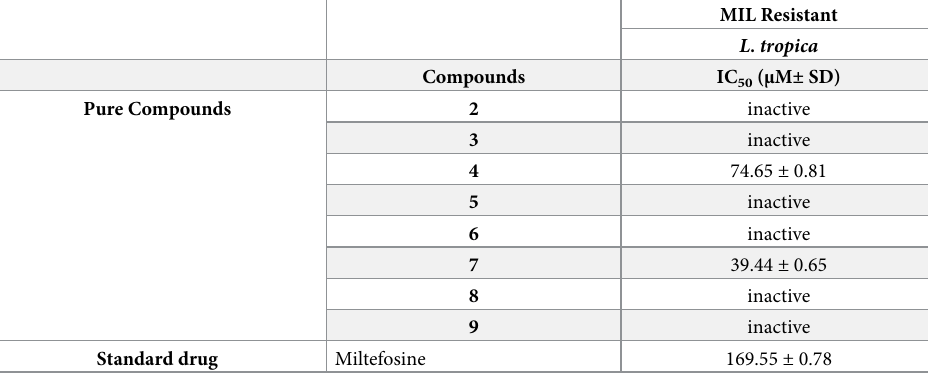
Table 8. Anti-leishmanial activity of compounds 2–9 against the MIL-resistant L . tropica